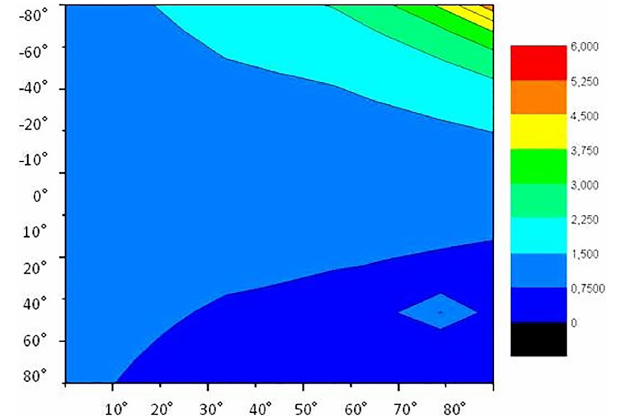
Figure 5. Scattering coefficient dependence on the incident and re- flection angle of the